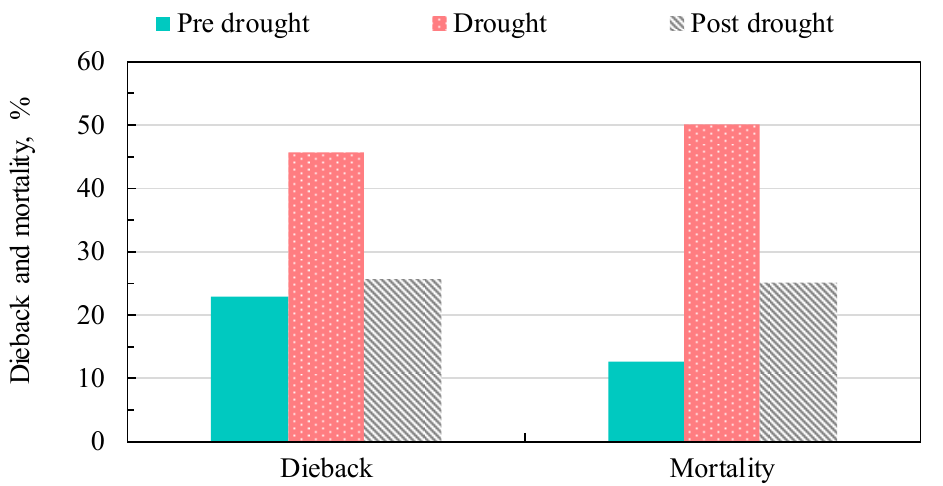
Figure 7. Percentage of dieback and mortality during pre-drought (Dry season 2014 / 2015–wet season 2015), drought (Dry season 2015 / 2016–wet season 2016), and post-drought (Dry season 2016 / 2017–wet season 2017).